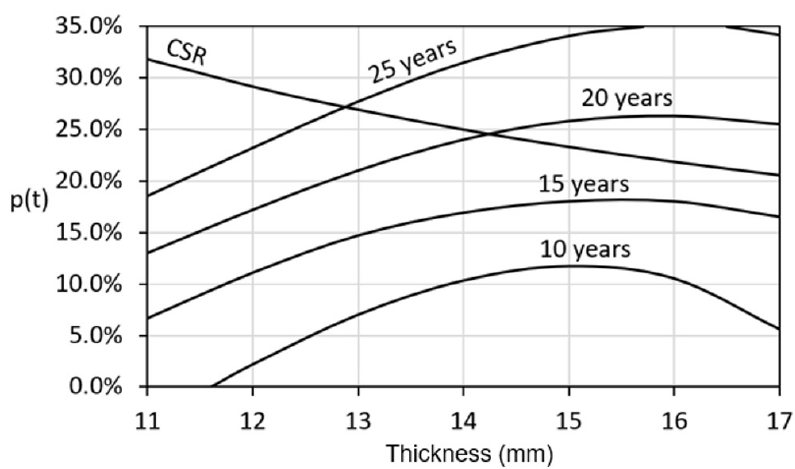
Figure 6. Corrosion depth percentage plotted against the thicknesses of LG: measured data vs. CSR corrosion addition